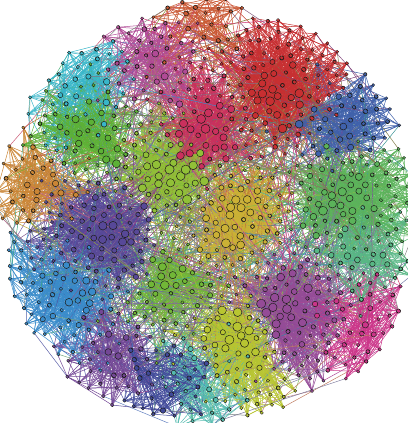
Figure 1: In heterogeneous networks, hub nodes are scattered in almost every communities. These hub nodes are the key starting point in community detection. Communities are distinguished by different colors, where node degree is marked by different Table 1: Description of main symbols. Notation Meaning